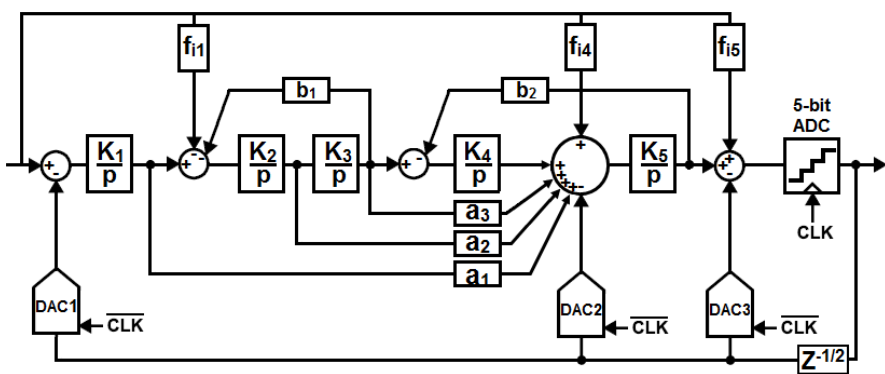
Figure 2. Architecture of the proposed ∆Σ modulator. (p is the Laplace variable).